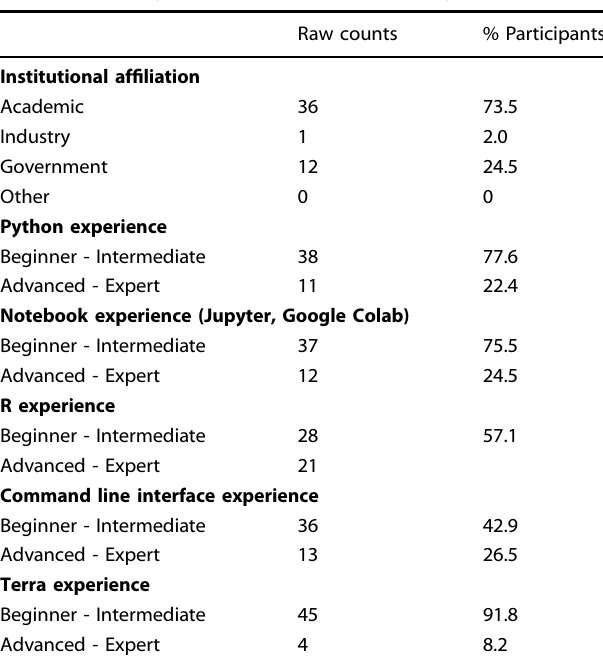
Table 1. Summary of hackathon participant